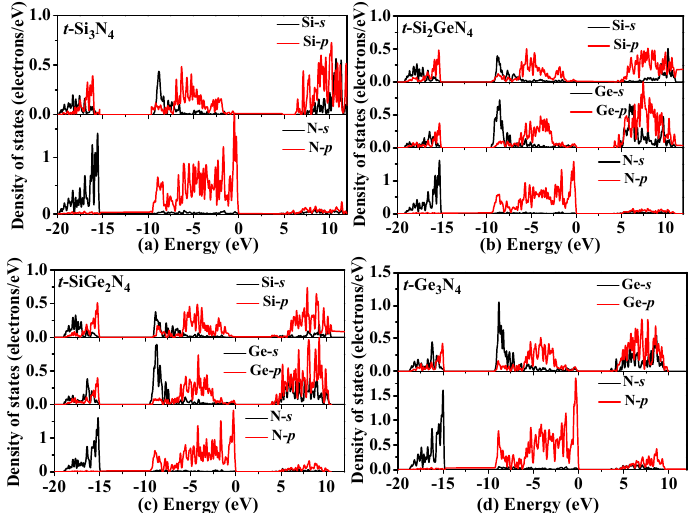
Figure 7. Comparison of total density of states and partial density of states for t -Si 3 N 4 ( a ); t -Si 2 GeN 4 ( b ); t -SiGe 2 N 4 ( c ); and t -Ge 3 N 4 ( d ). The black and red curves represent the s states and p states, respectively, of silicon, germanium, and nitrogen atoms.